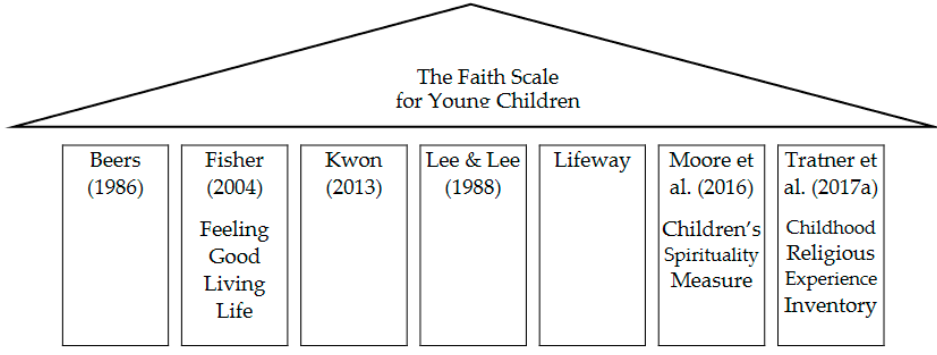
Figure 2. Theoretical foundation.